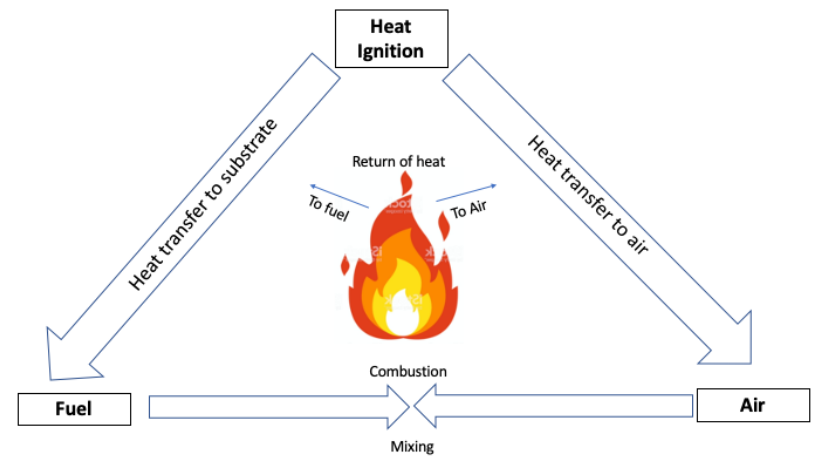
Figure 1. A self-sustaining combustion cycle (i.e., Emman’s fire triangle) for flammable materials.